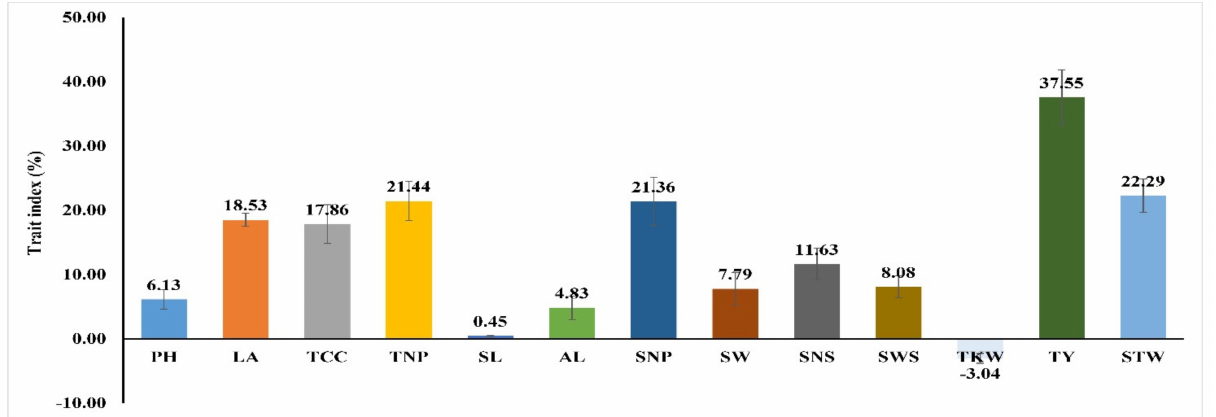
Figure 5. Percentage responses (increasing or decreasing index) of various studied characteristics across all accessions of barley under MOE application compared to control plants. PH: plant height, LA: leaf area, TCC: total chlorophyll content, TNP: number of the tillers per plant, SNP: number of the spikes per plant, SL: spike length, AL: awan length, SW: spike weight, SNS: number of seeds per spike, SWS: seed weight per spike, 1000-KW: 1000-kernel weight, TY: total yield per plot, STW: straw weight per plot. Positive and negative scores on the bars reflect the values of increasing and decreasing traits, respectively.